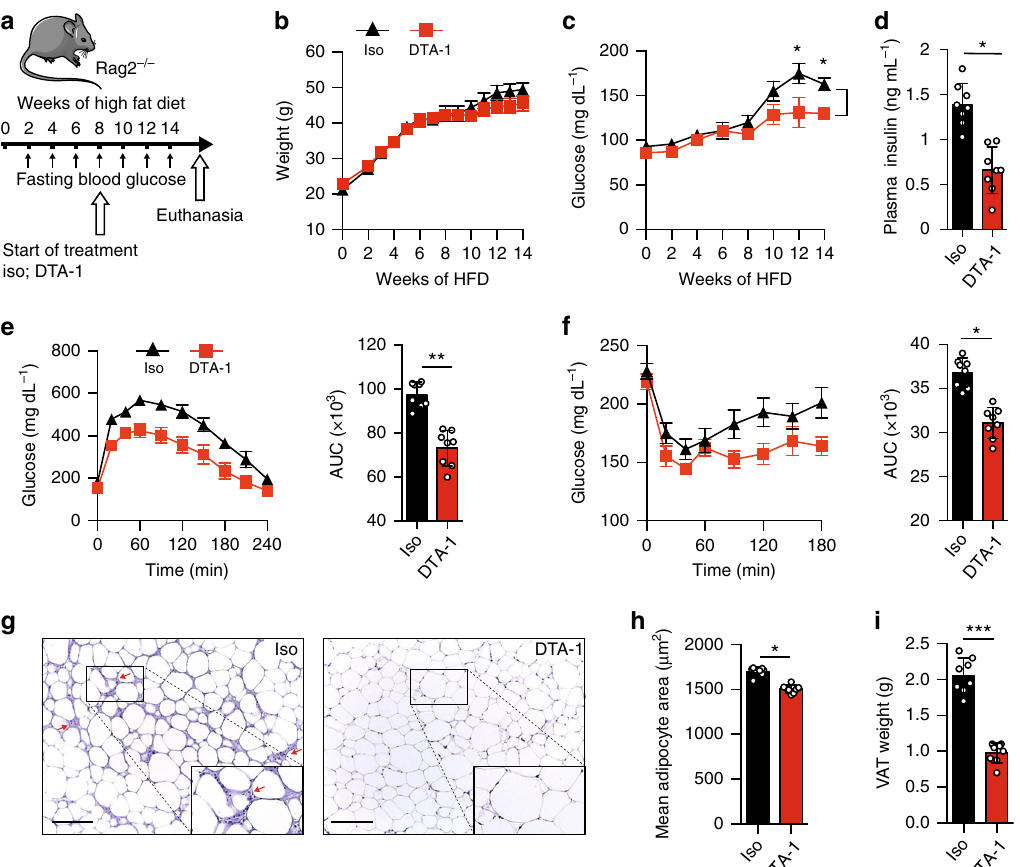
Fig. 5 Therapeutic GITR treatment ameliorates established Type 2 Diabetes in Rag2 -/- mice. a A cohort of Rag2 -/- mice were fed on HFD for 14 weeks. After 8 weeks, mice were either treated with DTA-1 (1 mg/mouse) or isotype control by intraperitoneal injection every four days according to the scheme, n = 8. b Total weight and c fasting blood glucose levels were measured every two weeks for 14 weeks. d Plasma insulin concentration was measured by ELISA. e Glucose tolerance test and f insulin tolerance test were performed in a cohort of mice after 8 weeks of treatment. The corresponding area under the curve was calculated for each group. g Hematoxylin and eosin-stained epididymal adipose tissue sections (×400). Red arrows point to recruited in fl ammatory cells around adipocytes, scale bars, 100 µ m. h Corresponding quantitation presented as the mean adipocyte area. i Weight of the VAT (epididymal adipose tissue) after 8 weeks of treatment. Error bars are the mean ± SEM. Student ’ s t-test, p < 0.05, ** p < 0.01, *** p < 0.001. Mouse image provided with permission from Servier Medical